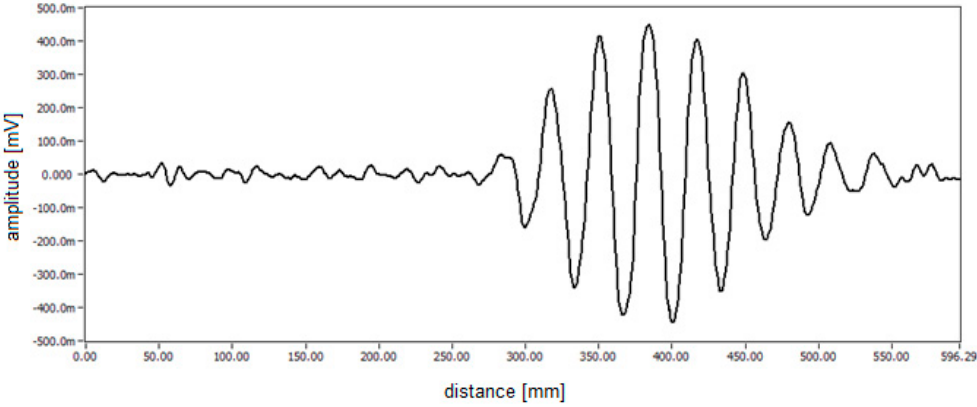
Figure 17. Collected Signal with the fiber Bragg grating with a tone burst excitation (57 KHz and 7 cycles).